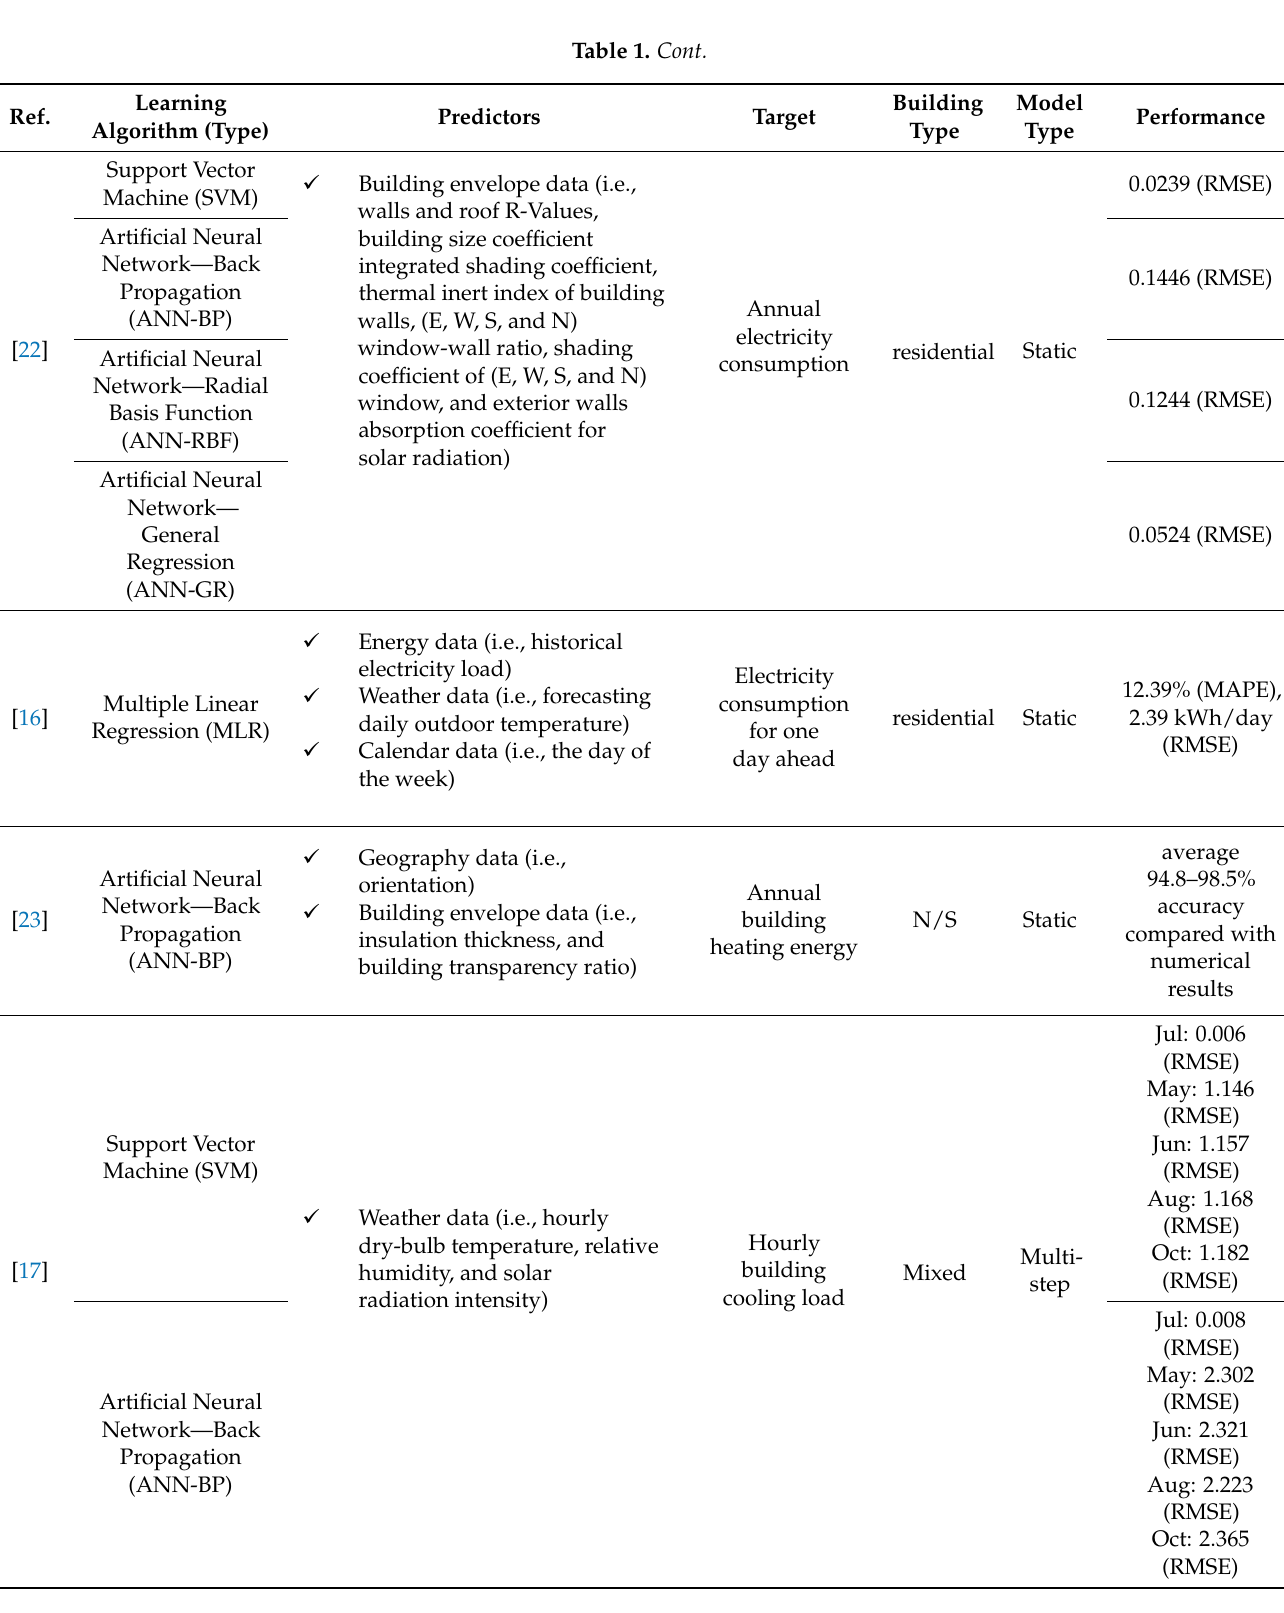
Table 1. Summary of prior research in predicting energy consumption in residential buildings. Table 1. Cont.